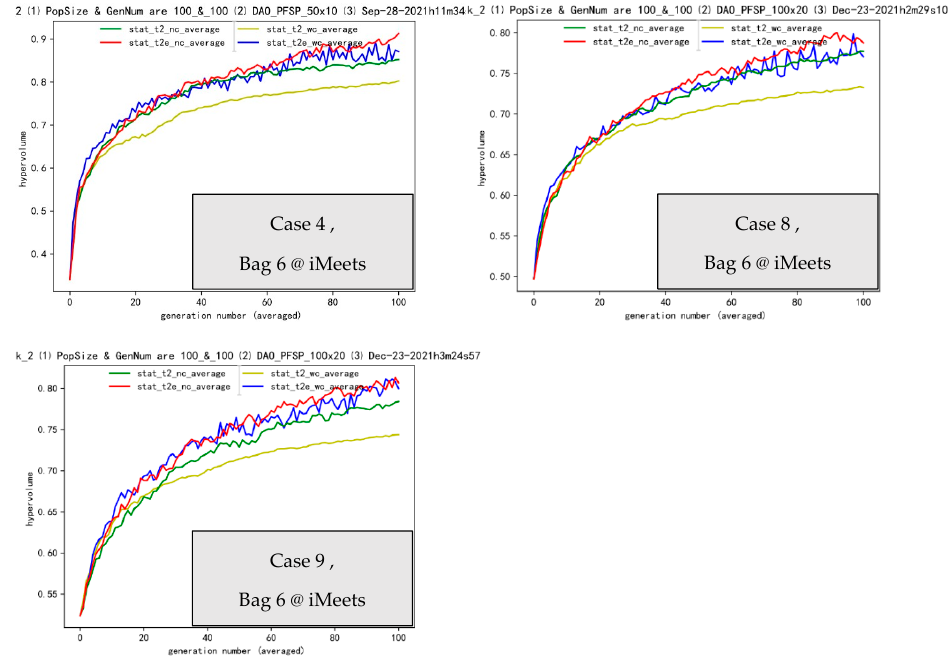
Figure 8. Cases 1, 2, ..., 9 are shown above. Those cases are for Bag 6 towards further insights in